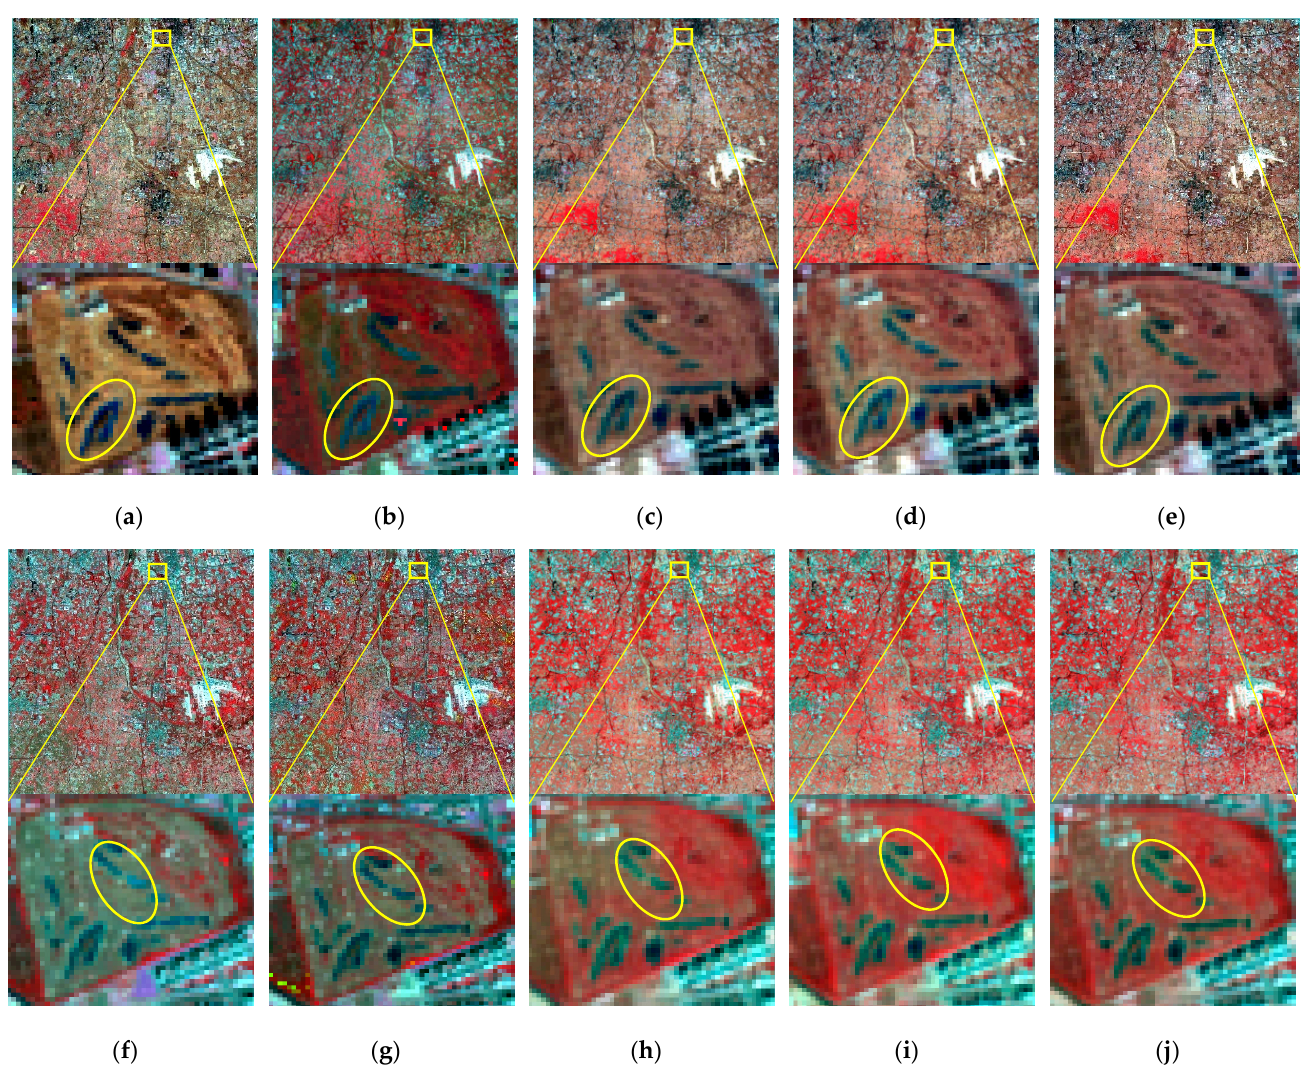
( c ) Figure 16. Network models used in the ablation experiment: ( a ) Only edge; ( b ) Edge-FA-encoder; and ( c ) Edge-FA-decoder. The three kinds of network training results are shown in Figure 17, which illustrates that adding modules results in a substantial improvement in the effectiveness of spatio-